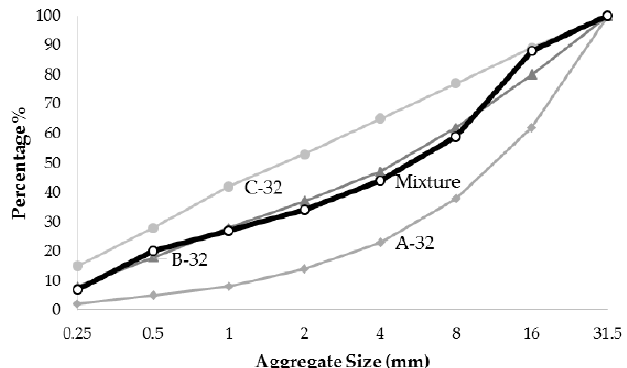
Figure 1. Mixture design. Table 1. Mixture proportions used for the test series.